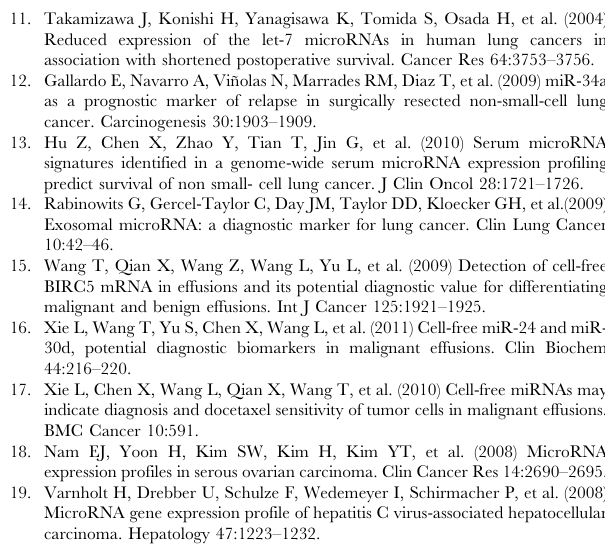
Figure S1 The volcano plot shows the differentially expressed miRNAs in effusions between longer-survival group and shorter-survival group. The horizontal axis represents the fold change between two groups. The vertical axis represents the P-value of the t-test for the differences between samples. (TIF) Figure S2 GO and pathway analysis based on miRNA targeted genes. The vertical axis is the GO (A) and pathway (B) category, and the horizontal axis is the enrichment of GO and pathways. (TIF) Figure S3 miRNA–mRNA network. Red box nodes represent miRNA and blue cycle nodes represent mRNA. Edges show the inhibitory effect of miRNA on mRNA. The center of the network was represents by degree, which means the contribution one MicroRNA to the genes around. miRNA-93 have the biggest degrees. (TIF) Table S1 MiRNAs that are differentially expressed in effusions between longer-survival group and shorter- survival